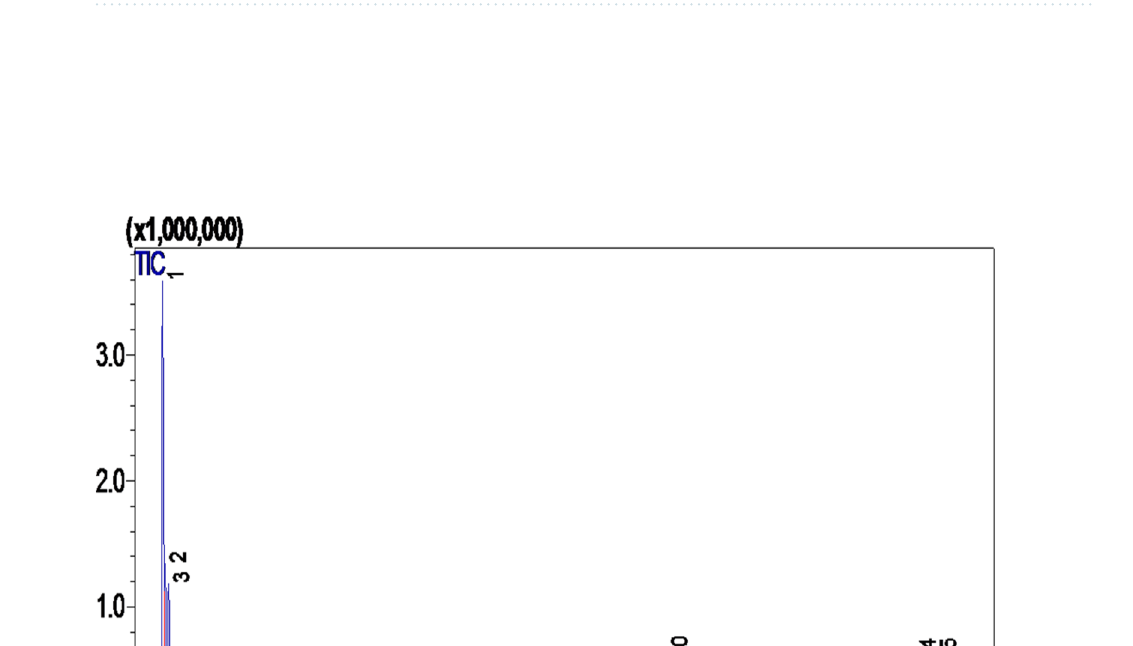
Table 8. GCMS of Dodonaea viscosa flowers compounds. Data were obtained by triplicate readings with mean and standard deviation.